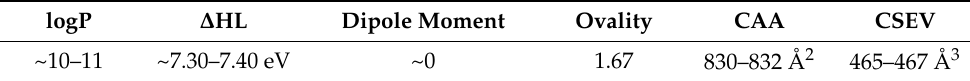
Table 19. Characteristics of the metal-phthalocyanins with highest affinity for